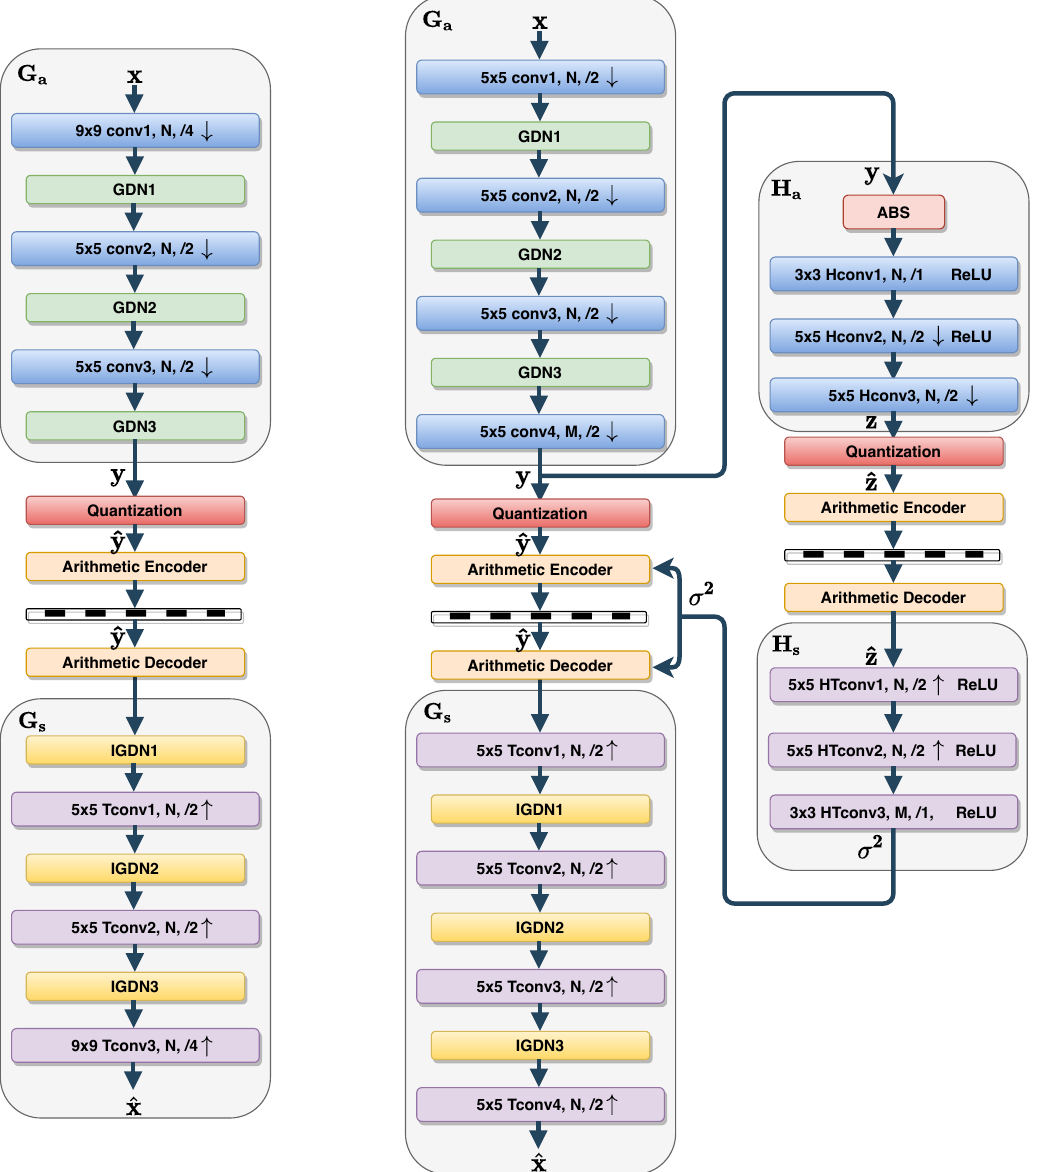
Figure 1. Architecture of the autoencoder [13] ( left ) and of the variational autoencoder [16] ( right